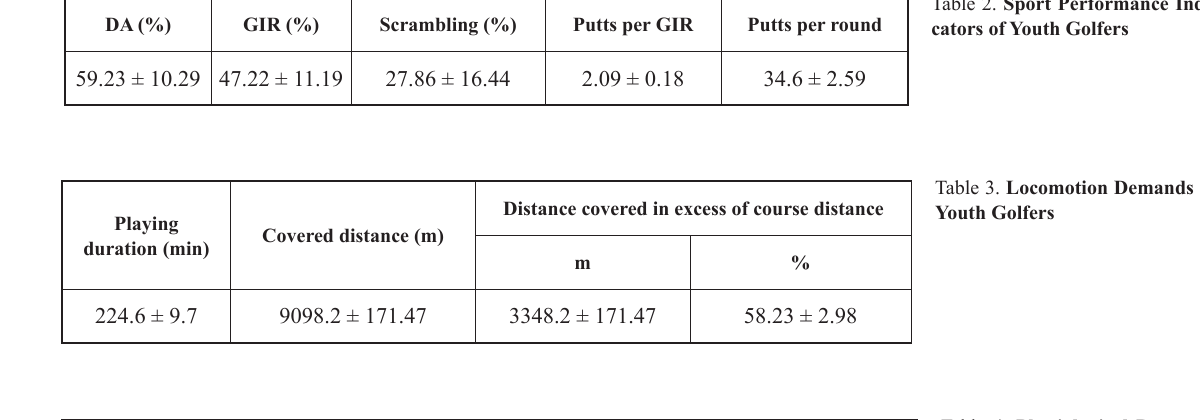
Table 4. Physiological Demands of Youth Golfers